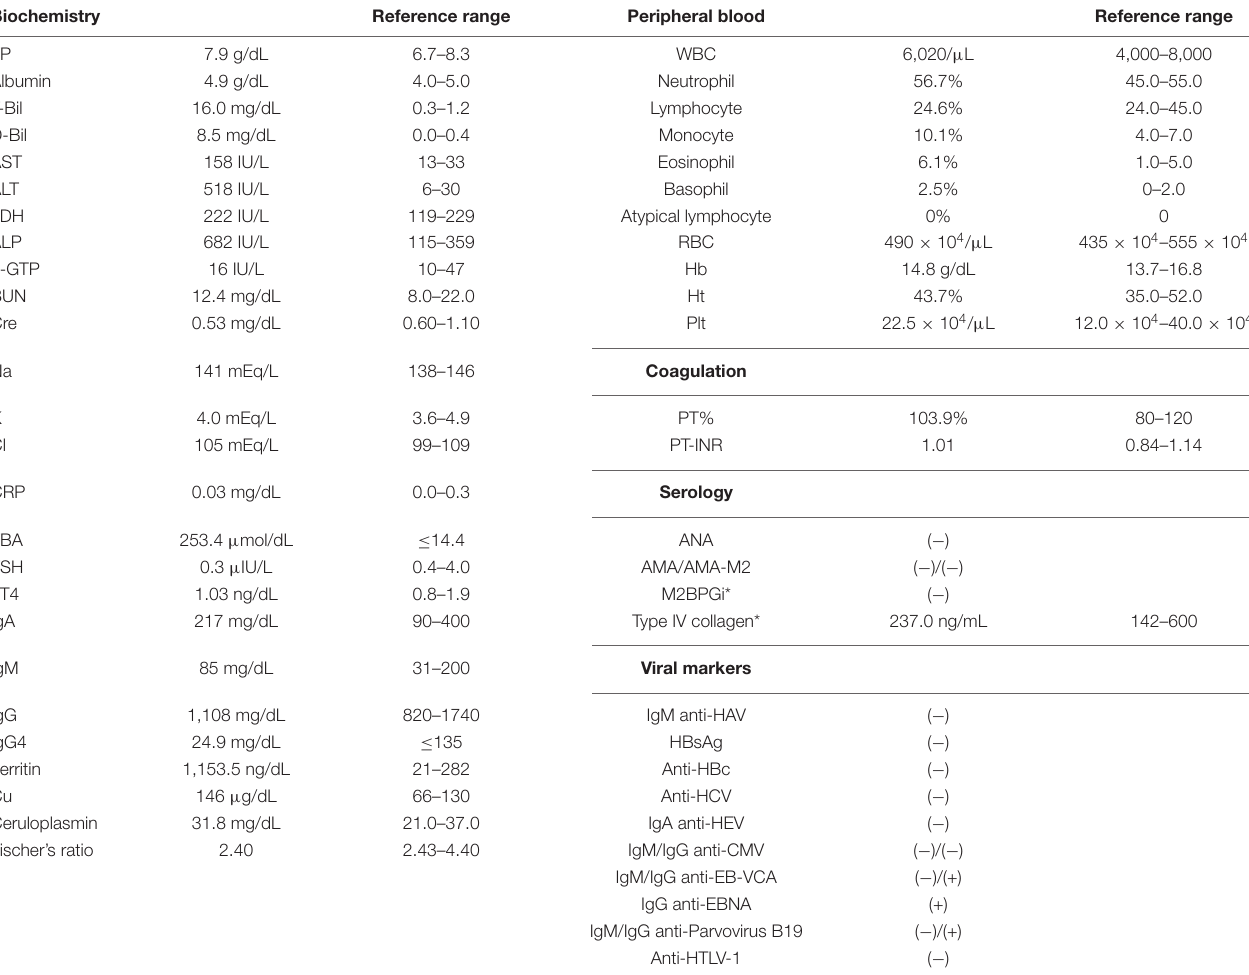
TABLE 1 | Laboratory data on admission at previous